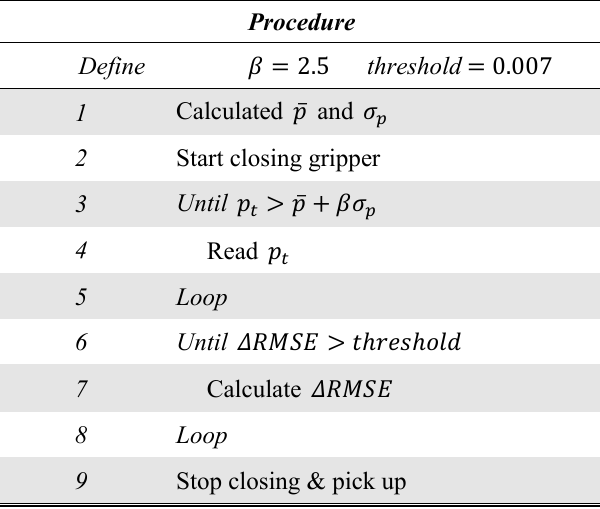
Figure 6. Procedure of the proposed strategy for detecting the CP: p and σ p denote the average and standard deviation, respectively, of the fluid pressure when the fingertip is unloaded and β is a tuning parameter. Threshold is the threshold for ∆ RMSE, which is the difference between the root mean square errors (RMSEs) when fitting with the two- and three-dimensional polynomial functions.